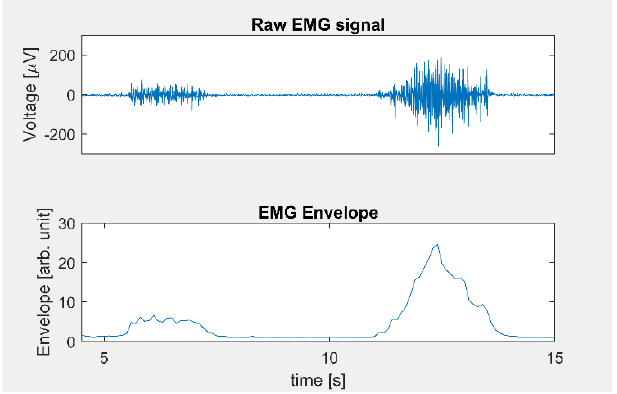
Figure 3. Raw EMG signal and its computed envelope for two different strength contractions of the forearm muscles. Envelope amplitude was normalized to its baseline level without